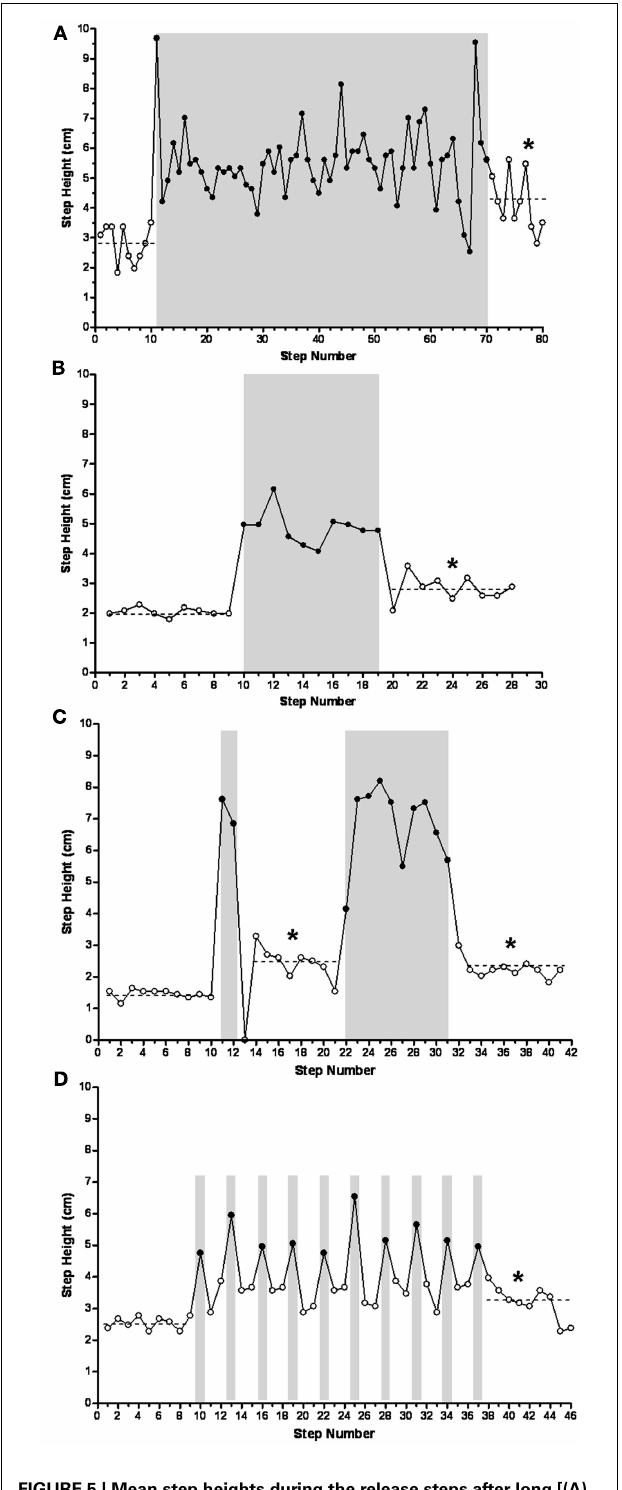
FIGURE 5 | Mean step heights during the release steps after long [(A) 60 trip steps], short [(B) 10 trip steps and (C) 2 and 10 trip steps], and single [(D) trip every third step] trip series were higher than during the control steps ( P ≤ 0.005), reflecting a learning-related phenomenon. Solid symbols, trip steps; open symbols, control steps; shaded areas, trip series. *Significantly different from